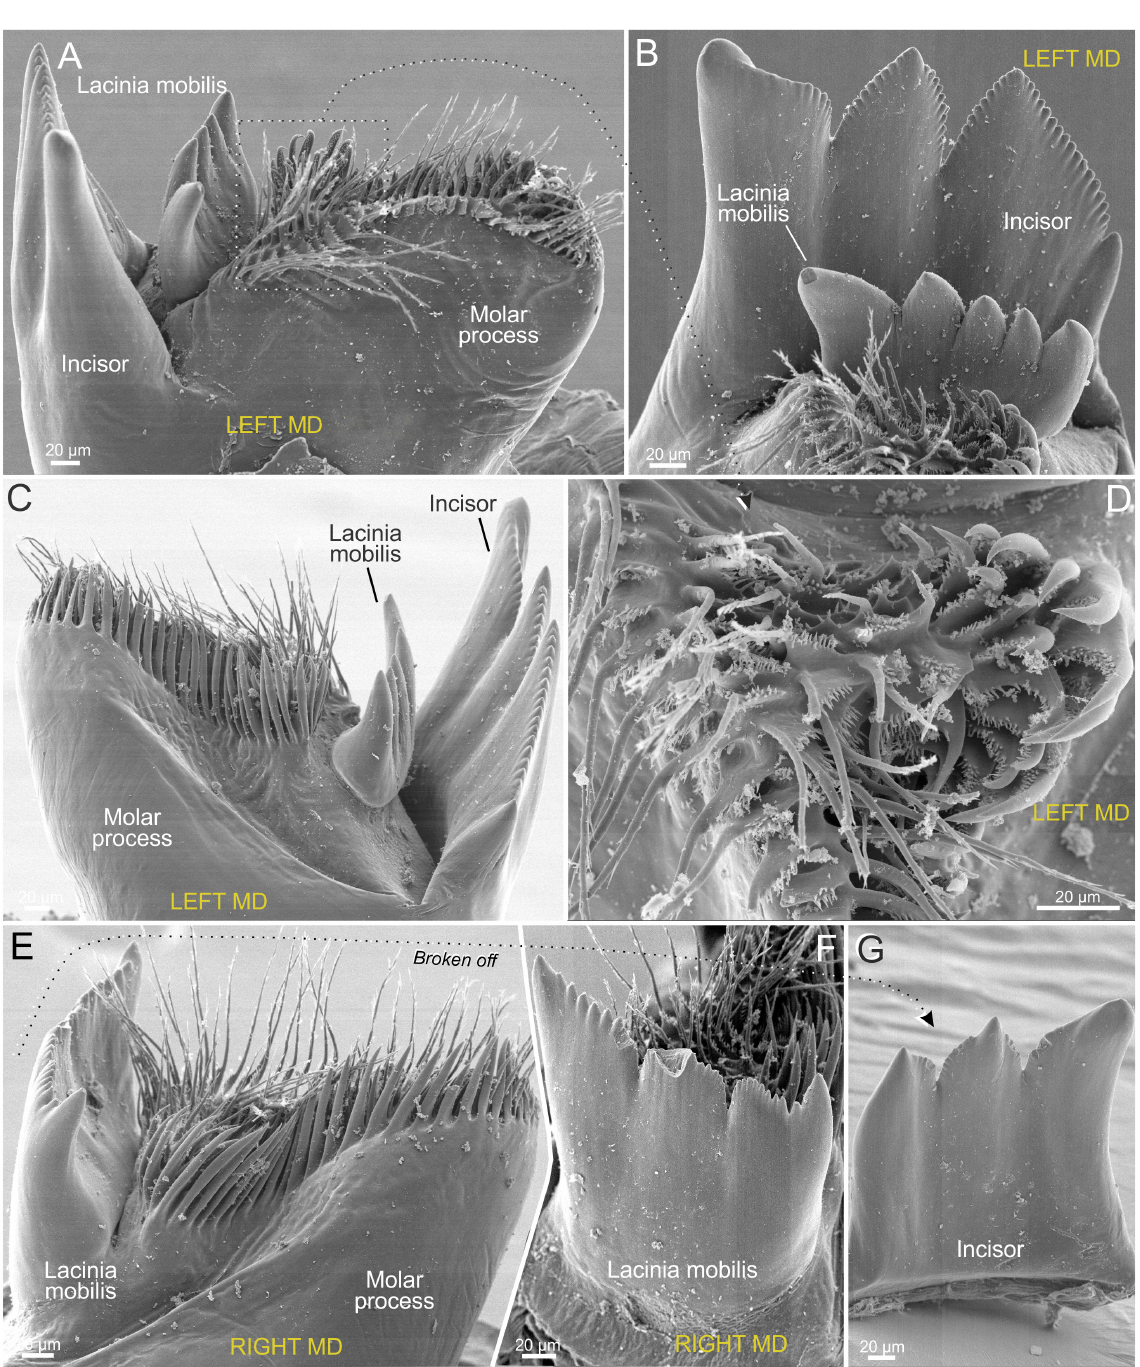
Fig. 5. Godzillius louriei sp. nov., holotype (NHMD 669698), scanning electron microscopy. A . Left mandible (md), anterior view. B . Left md, apical view of the lacinia mobilis and incisor. C . Left md, posterior view. D . Left md, apical view of the setae within the molar process. E . Right md, posterior view; incisor unintentionally removed in dissection. F . Right md, ventral view of the gnathal edge without the incisor. G . Right md, ventral view of the